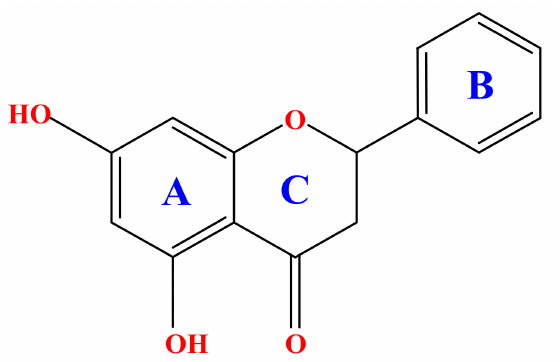
Scheme 1. Core structure of a flavonoid exemplified into the molecular structure of